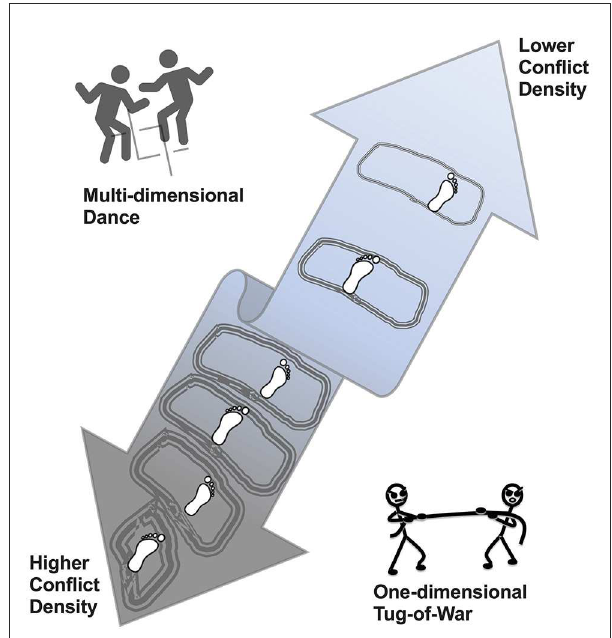
FIGURE1 An illustration of a path for a dyadic relationship like reiterated prisoner’s dilemma. The central double-arrow ribbon symbolizes the bidirectional path for movement of a dyadic relationship such as that between players in a reiterated prisoner’s dilemma. Inside the ribbon, irregular shapes symbolize conflicts as stepping stones on the path, wherein each conflict means that there is a win–lose or lose–win scenario happening in the reiterated prisoner’s dilemma. The footprints on those stepping stones symbolize a player’s movement in a direction from bottom to top, showing that the conflict density would decrease along the way, probably due to his or her practice of Tit-for-Tat with Forgiveness strategy. The icon on the upper left corner indicates that the nature of the reiterated prisoner’s dilemma is non-zero-sum, like a multidimensional dance. The icon on the lower right corner indicates that the nature of